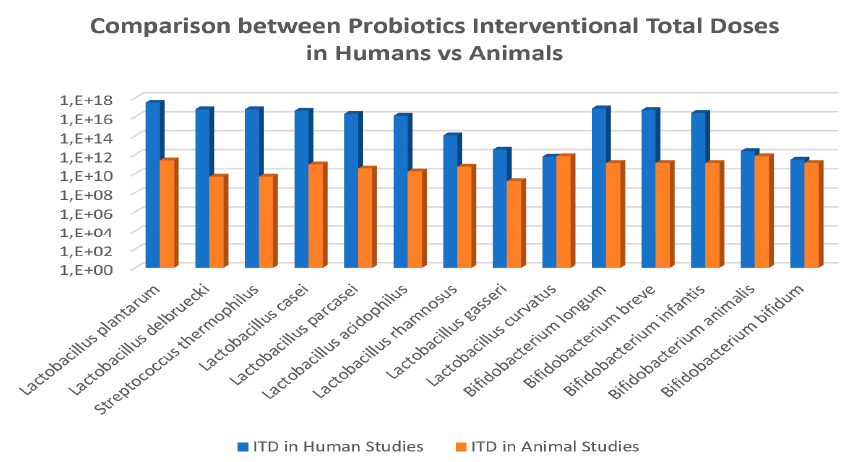
Figure 5. Comparison of interventional total doses (ITD) for common probiotic species administered to humans vs. animals in obesity-related disorders.